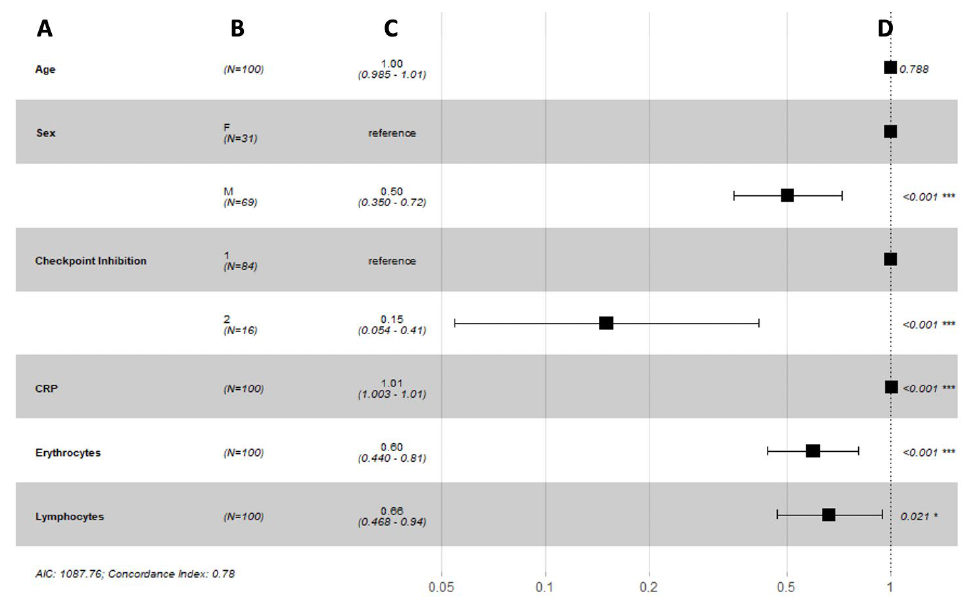
Figure 5. Forest plots summarizing the results of a Cox proportional hazard model analysis of overall survival with time-varying covariates: ( A ) variable; ( B ) number of patients; ( C ) hazard ratio (95% CI); ( D ) p -value. Abbreviations: F = female, M = male, 1 = single ICI, 2 = double ICI, CRP = c-reactive protein, AIC = Akaike information criterion. * and *** indicate significance at the 0.1 and <0.01 levels retrospectively.